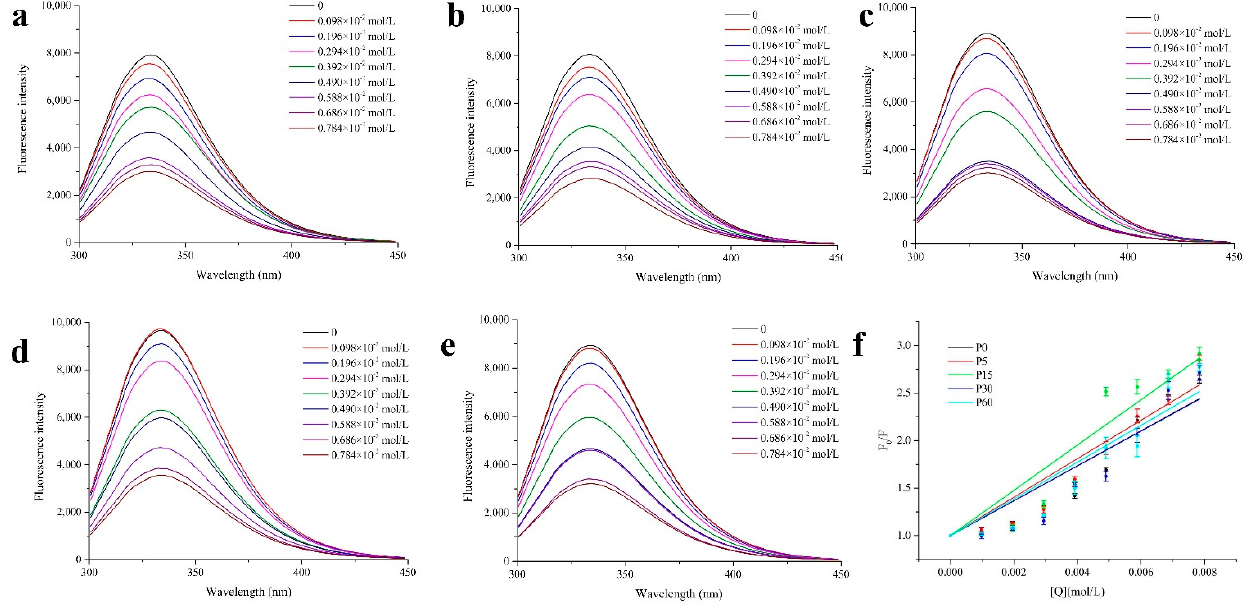
Figure 4. Fluorescence spectra analysis ( a – e ) and Stern–Volmer plots ( f ) of the interaction between octanal and the MP treated with papain at 0 ( a ), 5 ( b ), 15 ( c ), 30 ( d ) and 60 min ( e ).